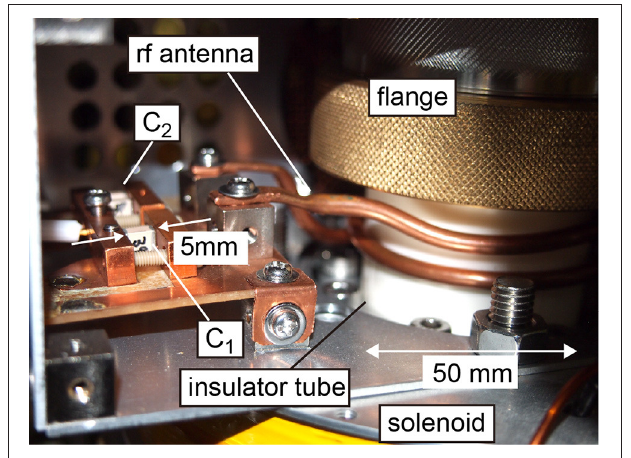
FIGURE 2 | Photograph of the plasma source and the impedance matching circuit consisting of the fixed ceramic capacitors.